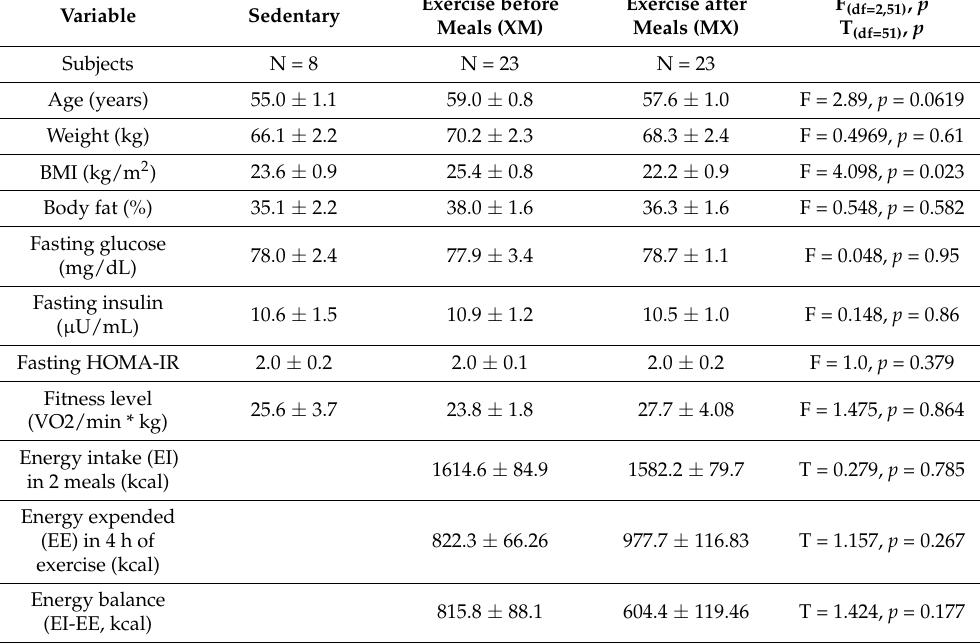
Table 1. Subject characteristics * and features of experimental